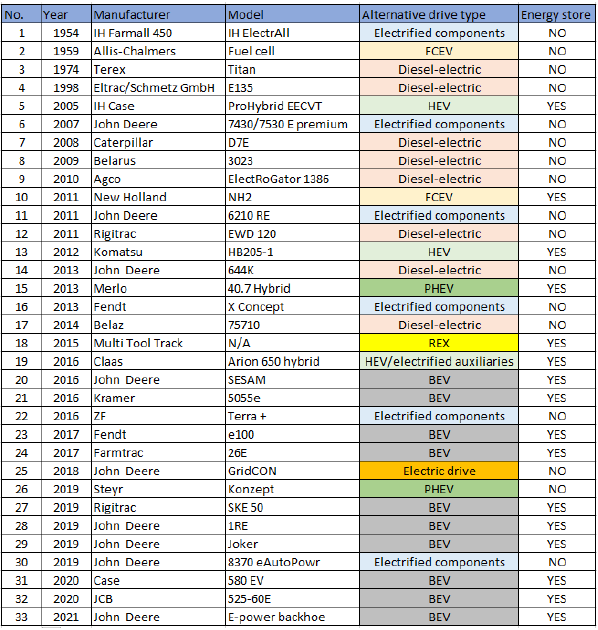
Fig. 1. List of selected alternative powertrain solutions for non-road ma-